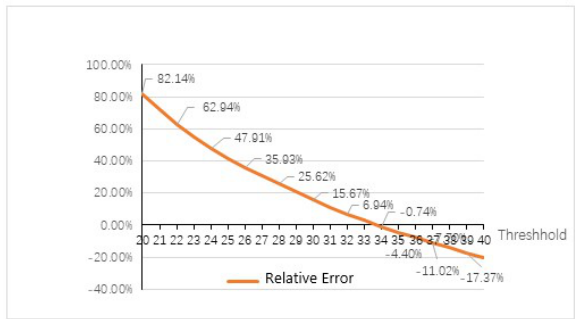
Figure 4 . Determination of lighting